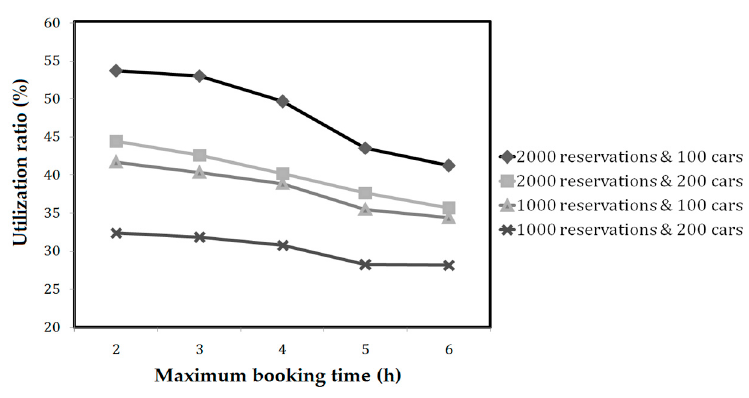
Figure 14. Impact of the booking time on the utilization ratio.